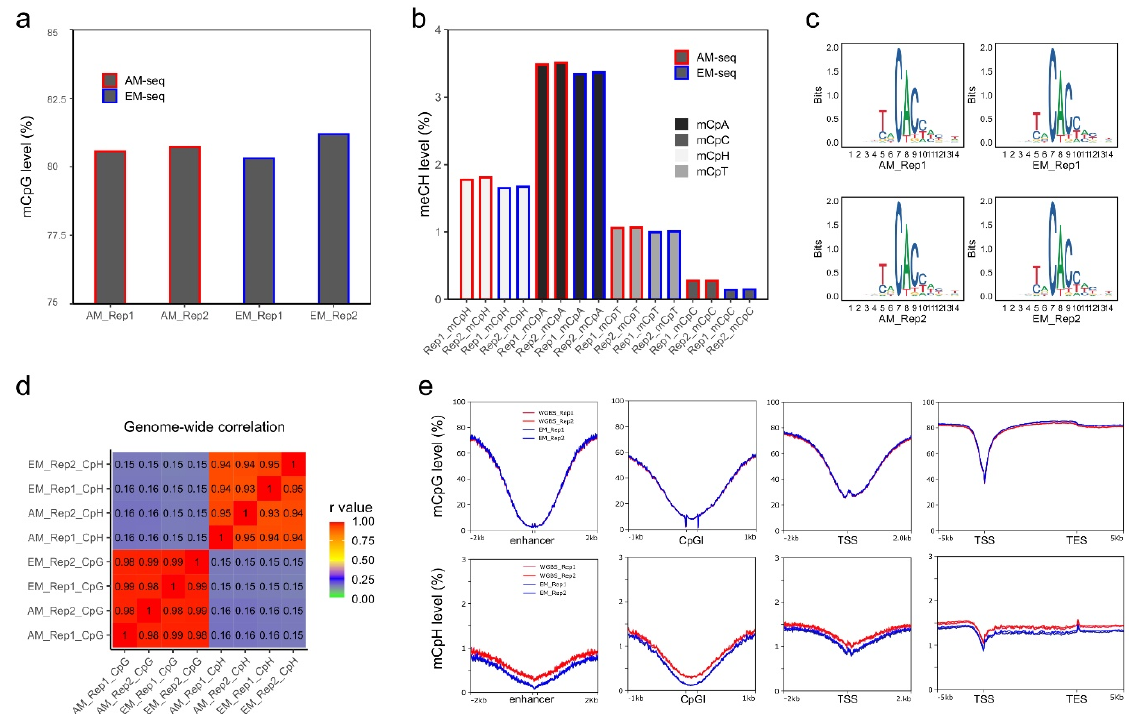
Figure 2. CpG and non-CpG methylation in NAc D2-MSNs. ( a ) Global CpG methylation levels calculated from AM-seq and EM-seq libraries. Y-axis starts from 75%. ( b ) Non-CpG methylation levels. mCpH represents the (methylated CpA, CpT, and CpC) / (total CpA, CpT, and CpC). ( c ) DNA motif of top hypermethylated non-CpG methylation sites. ( d ) Pearson correlation of mCpG and mCpH levels of the four methylome libraries using 10 kb bins. ( e ) Methylated CpG levels and methylated CpH levels at enhancers, CGIs, TSSs, and gene proximal regions using 50 bp bins.